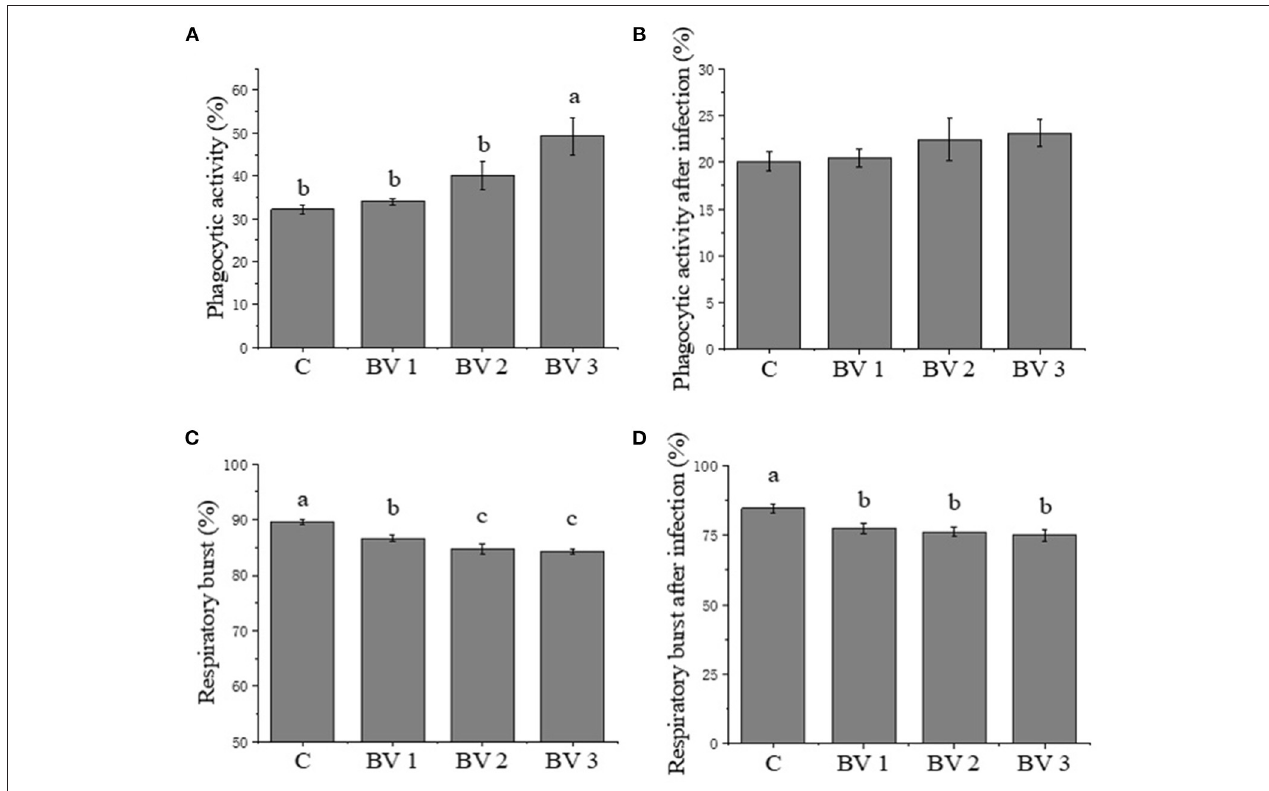
FIGURE 1 | (A-D) Phagocytic activity and respiratory burst activity of hemocytes in Litopenaeus vannamei fed diets containing Bacillus velezensis concentration of 0 CFU/g (C), 10 5 CFU/g (BV1), 10 7 CFU/g (BV2), and 10 9 CFU/g (BV3) for 6 weeks and then infected with Vibrio parahaemolyticus for 1 week. Error bars with different letters (a, b, c) represent statistically significant differences based on the least significant difference (LSD) method ( P < 0.05, one-way ANOVA). The results were shown as mean ± SE ( N = 12).